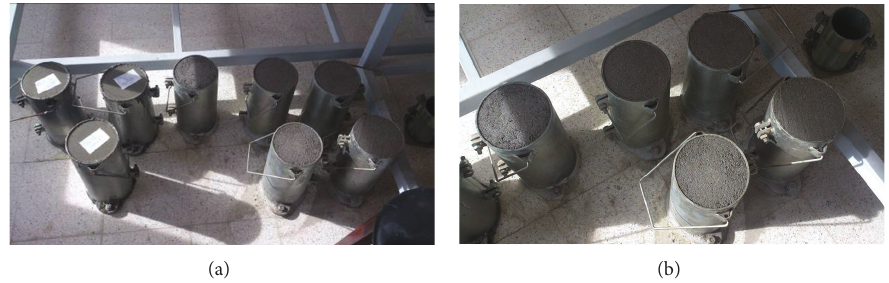
Figure 2: Viev of preparing the specimens in